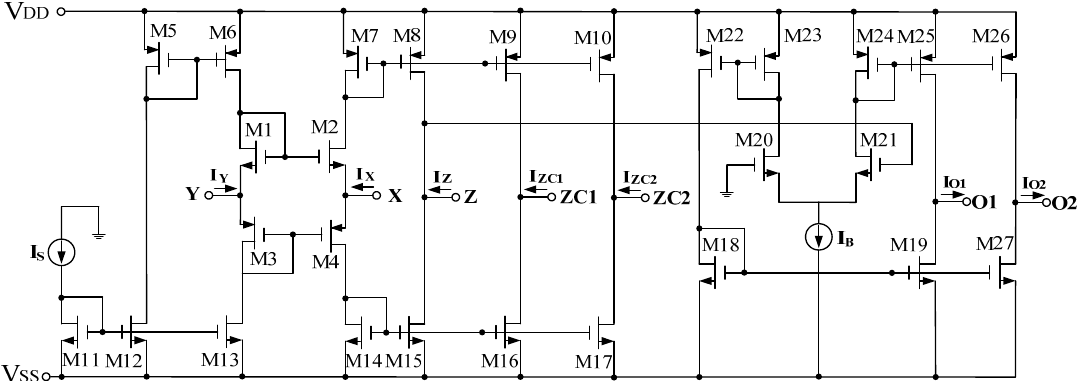
Figure 5. The internal construction of MO-CCCCTA. Appl. Sci. 2016 , 6 , 179